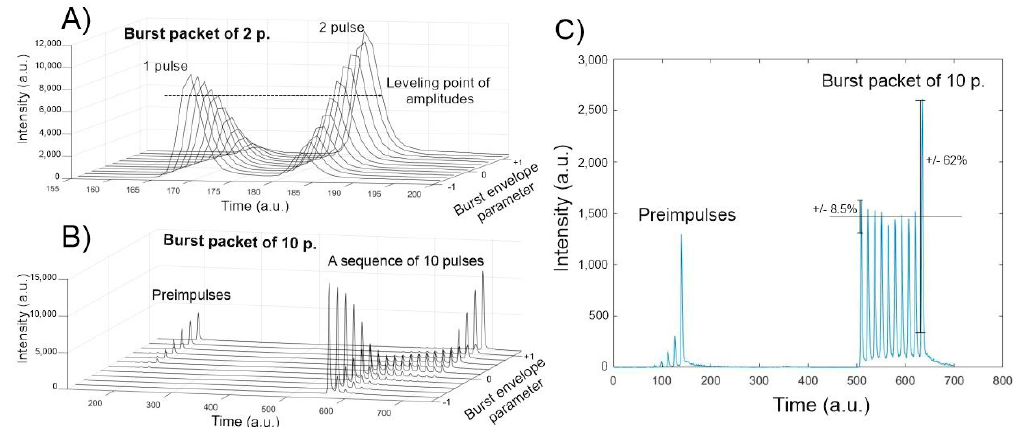
Figure 3. The dependence of the intensity of the sub-pulses in the burst versus the envelope parameter when a single pulse is divided into 2 sub-pulses ( A ) and into 10 sub-pulses ( B ). Amplitudes of a leveled burst packet of 10 sub-pulses are displayed in ( C ).